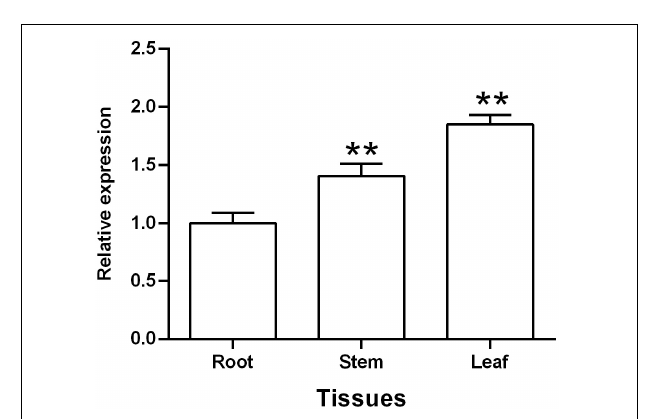
FIGURE 2 | Tissue-specific expression of TaGSL22 . Relative gene quantification was calculated by the comparative (cid:49)(cid:49) CT method. Data were normalized to the expression level of the wheat elongation factor TaEF-1 α . ** indicates a significant difference ( P < 0.01) from the root by Student’s t -test. Error bars represent SEM of three biological